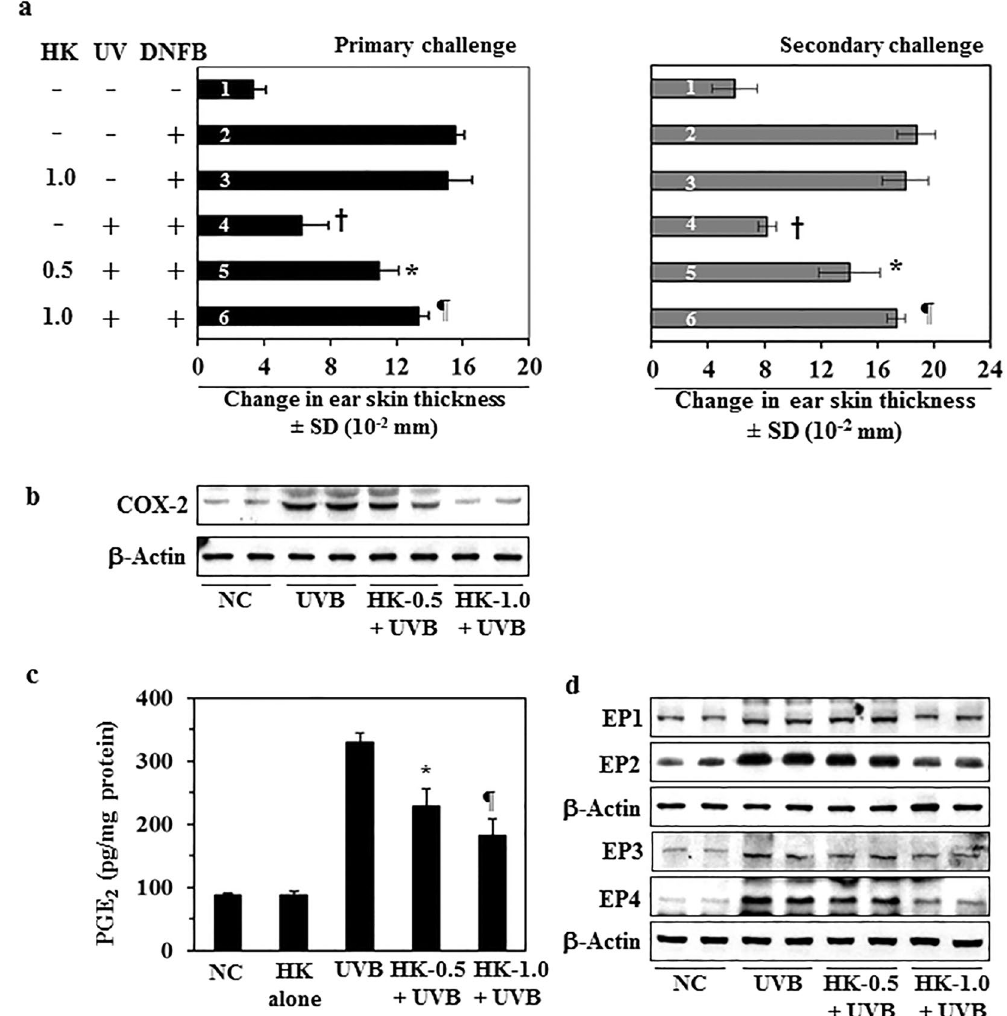
Figure 1. Topical application of honokiol inhibits UVB-induced suppression of the CHS response in mice through inhibition of inflammatory mediators. The clipper-shaved dorsal skin of female C3H/HeN mice was exposed to UVB radiation (150 mJ/cm 2 ) for four consecutive days. Honokiol (0.5 and 1.0 mg/cm 2 of skin area) was applied in a hydrophilic cream-based topical formulation before each exposure. ( a , left panel) The mice were then sensitized to DNFB, and the CHS response to application of DNFB on the ear skin (challenge) was assessed by measurement of the ear swelling 24 h later. The change in ear skin thickness (swelling) is reported in millimeter (mm × 10 − 2 ) as the mean ± SD, n = 4–5 per group. ( a , right panel), Long-term effects of honokiol tested by secondary challenge. Significant inhibition versus positive control group, † P < 0.001, significant increase in CHS response versus non-honokiol treated and UVB-irradiated mice, * P < 0.01; ¶ P < 0.001. ( b – d ) The mice were exposed to UVB (150 mJ/cm 2 ) radiation on four consecutive days with and without topical application of honokiol and sacrificed 24 h after the last UVB exposure. Dorsal skin samples from the mice were collected for analysis. ( b ) Topical application of honokiol inhibits UVB-induced COX-2 expression in mouse skin. COX-2 levels were determined using western blot analysis. ( c ) Topical application of honokiol inhibits the UVB-induced increase in the expression levels of PGE 2 . The concentration of PGE 2 in skin homogenates was determined using a PGE 2 immunoassay kit. PGE 2 concentration is expressed in terms of pg/mg protein as the mean ± SD. Significant inhibition versus non-honokiol-treated control group, * P < 0.01, ¶ P < 0.001. ( d ) The levels of the PGE 2 receptors (EP1, EP2, EP3, and EP4) were determined in skin samples using western blot analysis. For panel b and d, western blot data are shown. Samples was prepared by pooling the skin biopsies from at least two mice in each treatment group. NC, normal control